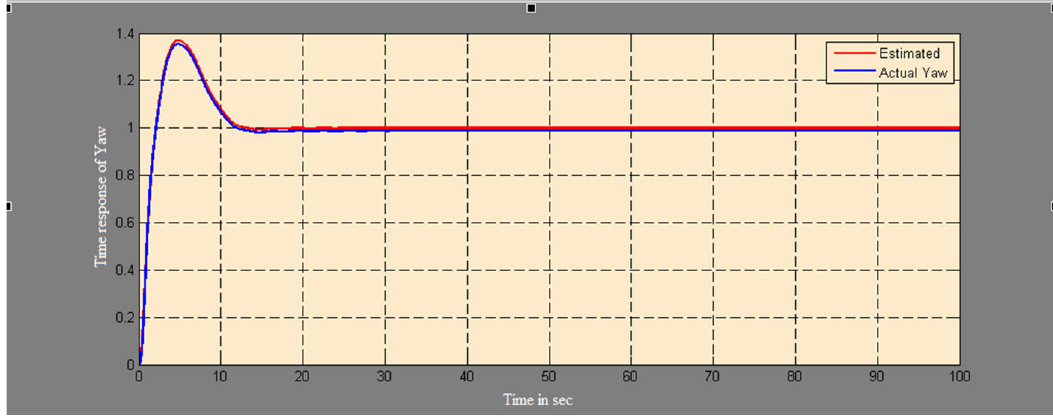
Figure 11. Estimation of yaw for a step input with Luenberger observer.